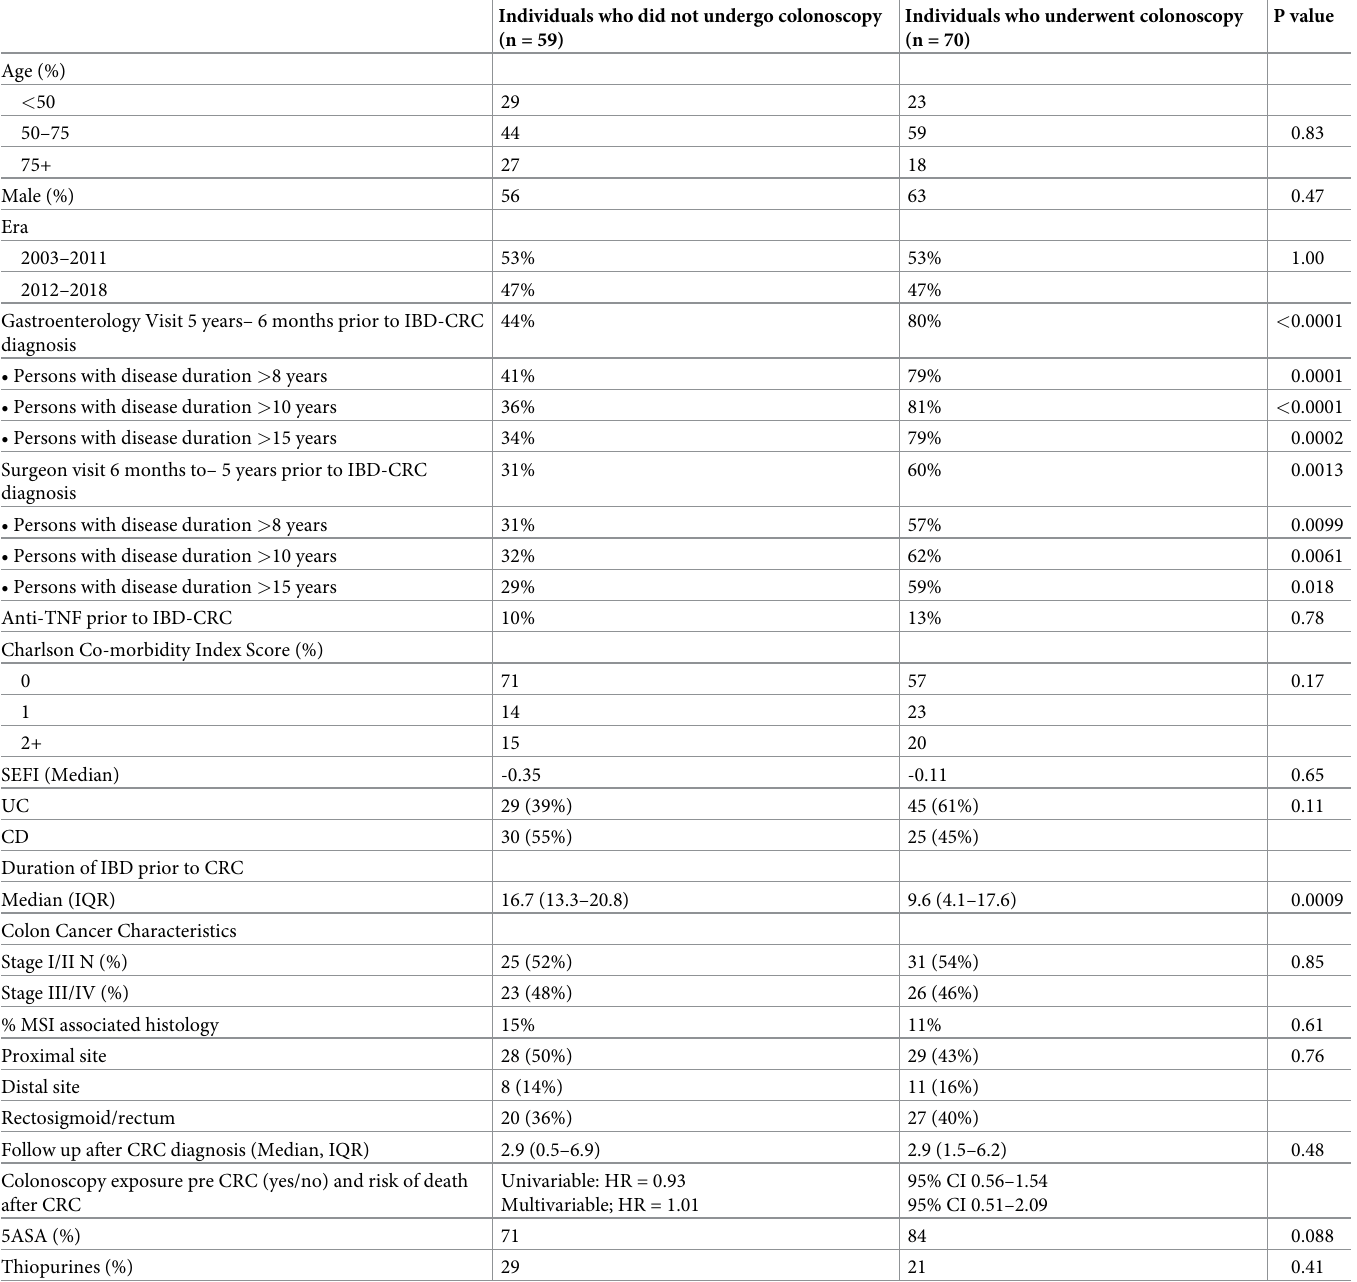
Table 4. Colonoscopy use in the 5 years to 6 months prior to IBD-CRC diagnosed in 2003–2018 �